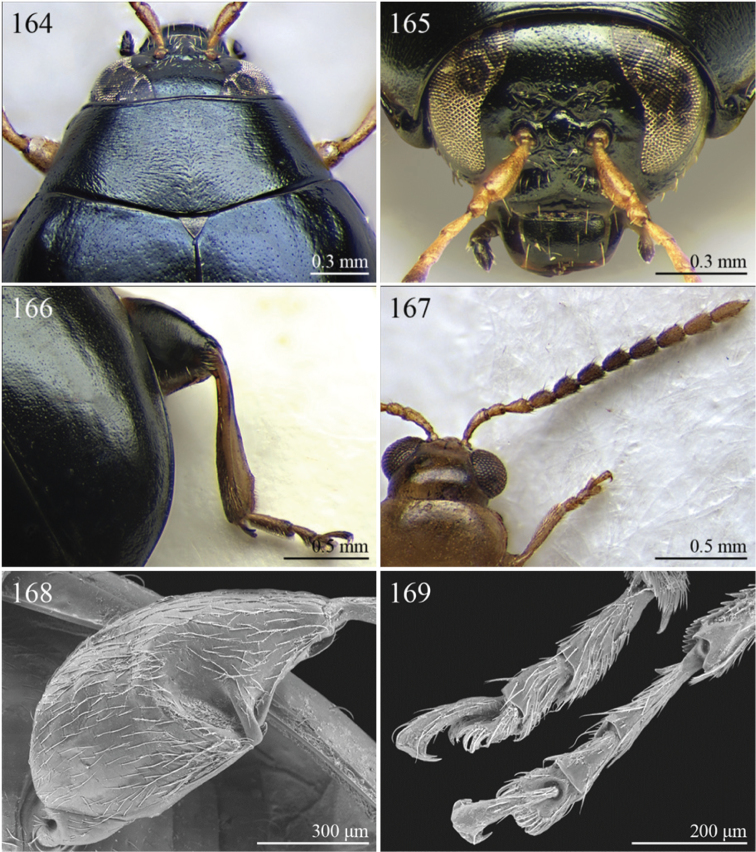
Morphological characters. 164
Dibolia thoracica Jacoby, head and pronotum in dorsal view 165 Ditto, head in frontal view 166 Ditto, hind leg and elytral punctation 167
Dimonikaea descarpentriesi Bechyné, head and right antenna in dorsal view 168 Ditto, dentiform process on ventral side of hind femora in male 169 Ditto, metatarsus in lateral (left) and dorsal (right) view.